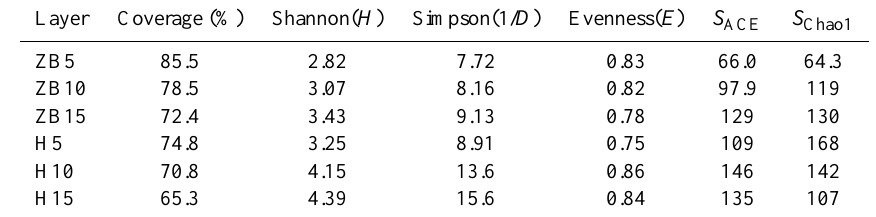
Table 4. Biodiversity and predicted richness of nirS sequences recovered from six layers in the Pearl River